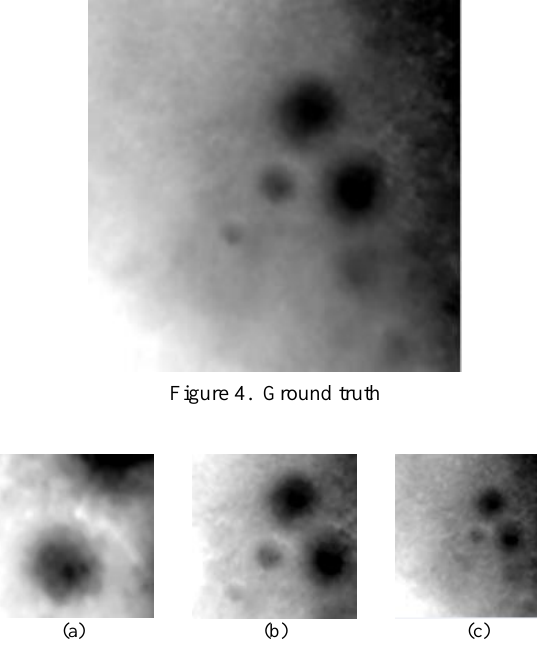
Figure 5. DEM of resolutions 0.075m,0.2m, 0.4m with different coverage